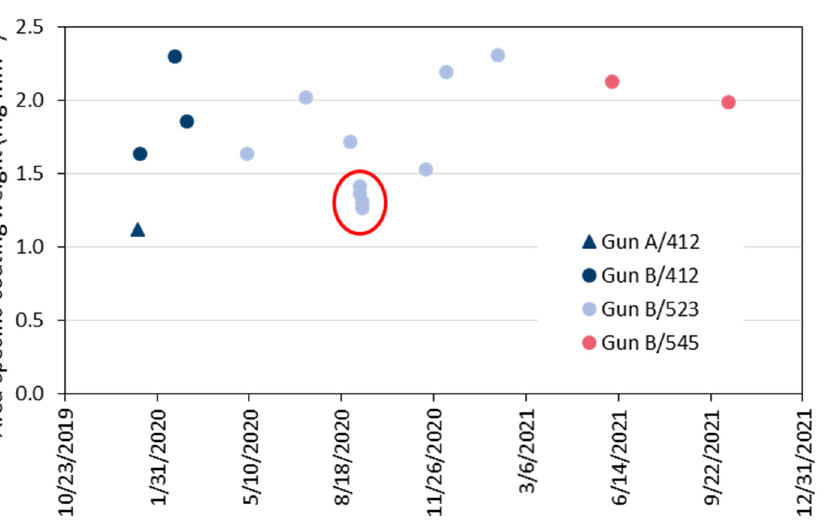
Figure 1. Variability of the area-specific coating weights on the sprayed test samples obtained in the period of 2020 and 2021 (see text for details).